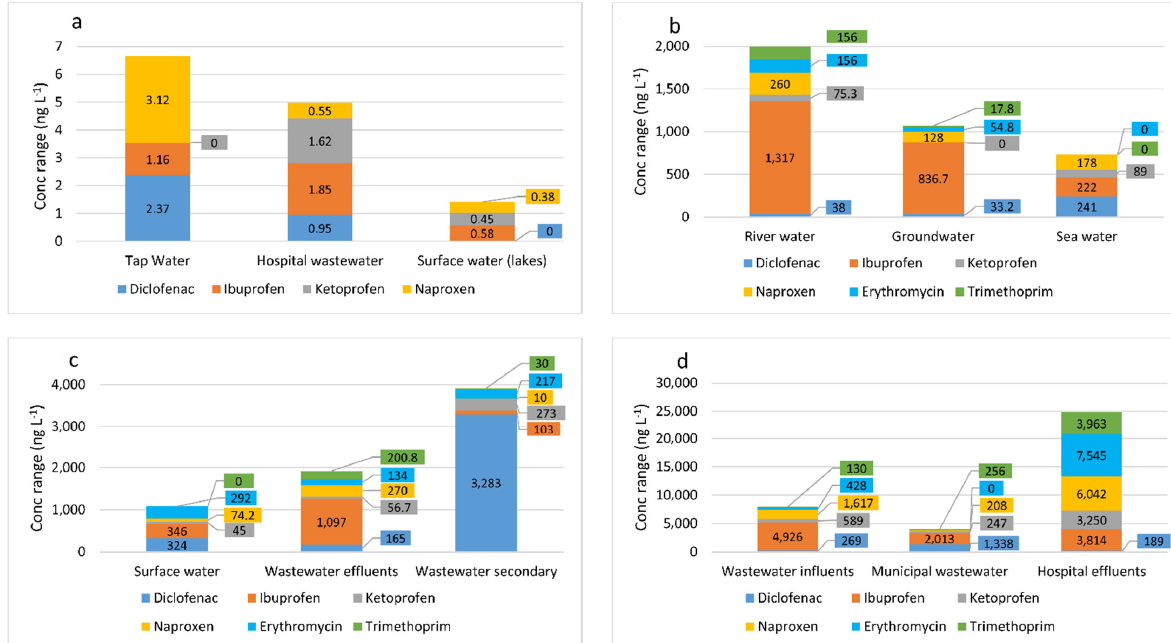
Figure 1. Concentrations of some pharmaceuticals (antibiotics, anti-inflammatory drugs, and analgesics) recorded in the world in selected water types: ( a ) tap water [25], hospital wastewater, and surface water (lakes) [26]; ( b ) river water, groundwater [27], and seawater [28]; ( c ) surface water [29], wastewater effluents, and wastewater secondary [27,30]; and